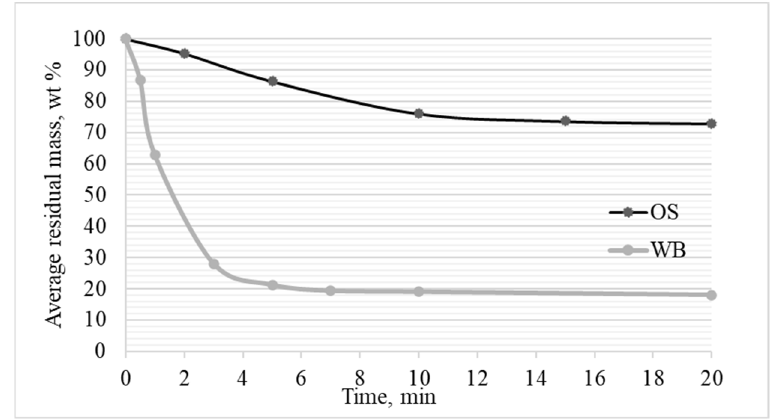
Figure 2. Residual mass from individual pyrolysis of OS and WB.